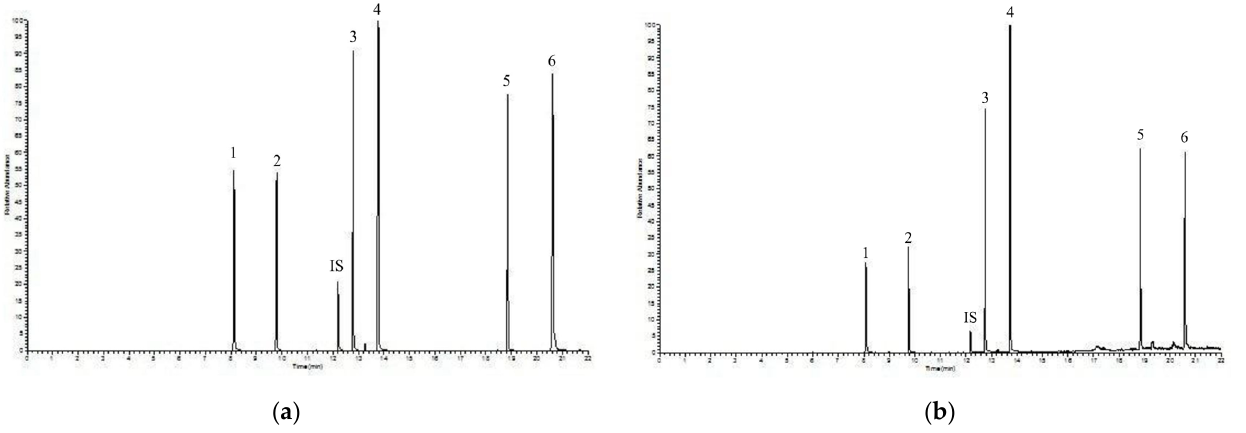
Figure 2. GC-IT/MS chromatograms of ( a ) PAEs standard solution, and ( b ) turtle blood sample spiked with a PAE solution at 75 ng mL − 1 . The graph reported the relative abundance (y axis) as a function of the time in min ( x axis). Peaks: 1—DMP; 2—DEP; 3—DiBP; 4—DBP; 5—DEHP; 6—DnOP; IS (Internal Standard)—phenanthrene. For acronyms: see Table 1. For experimental conditions: see text.